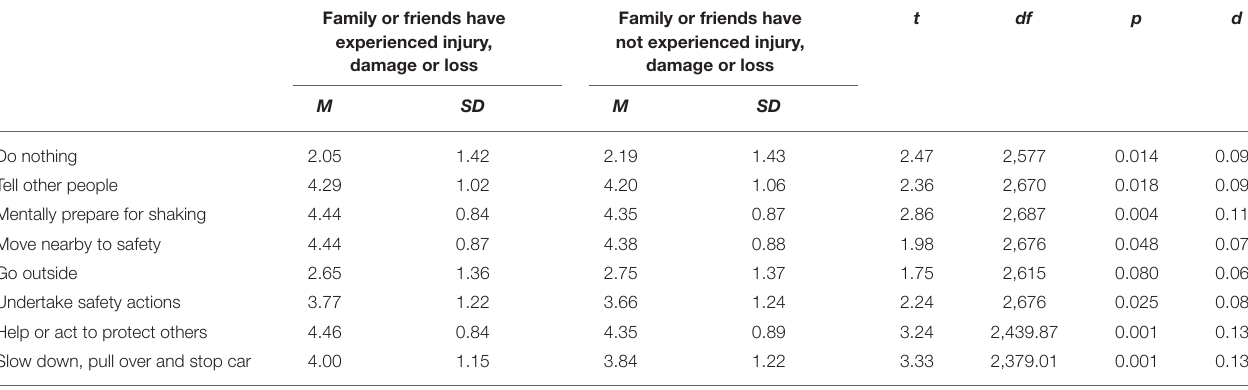
TABLE 2 | Results of independent samples t -tests comparing mean intentions scores for a range of actions between those who have and have not had family or friends injured, or experienced damage or loss from an earthquake. Family or friends have Family or friends have experienced injury, not experienced injury, damage or loss